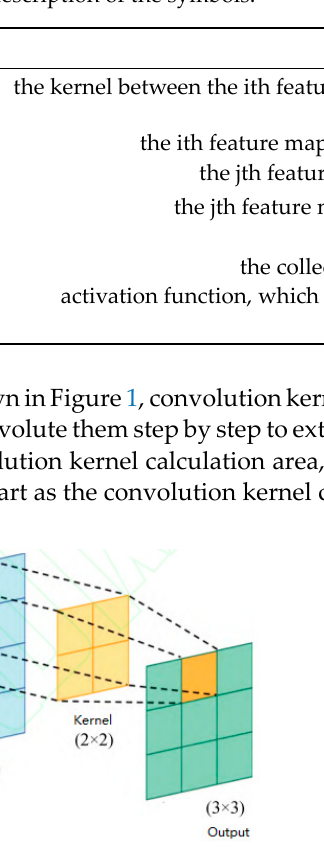
Figure 1. Convolution kernel calculation process.